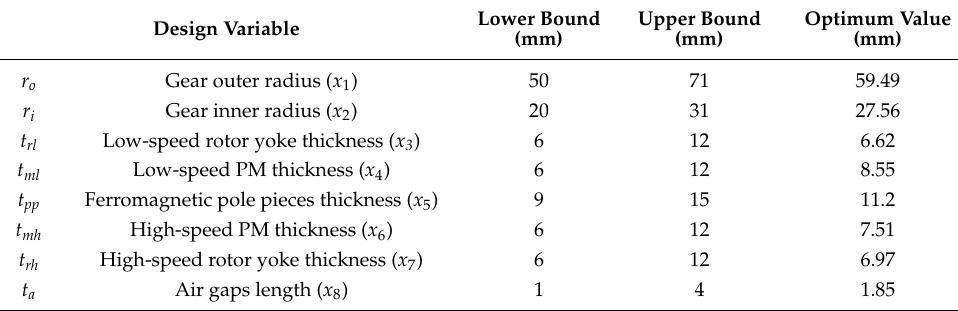
Table 2. Optimum design